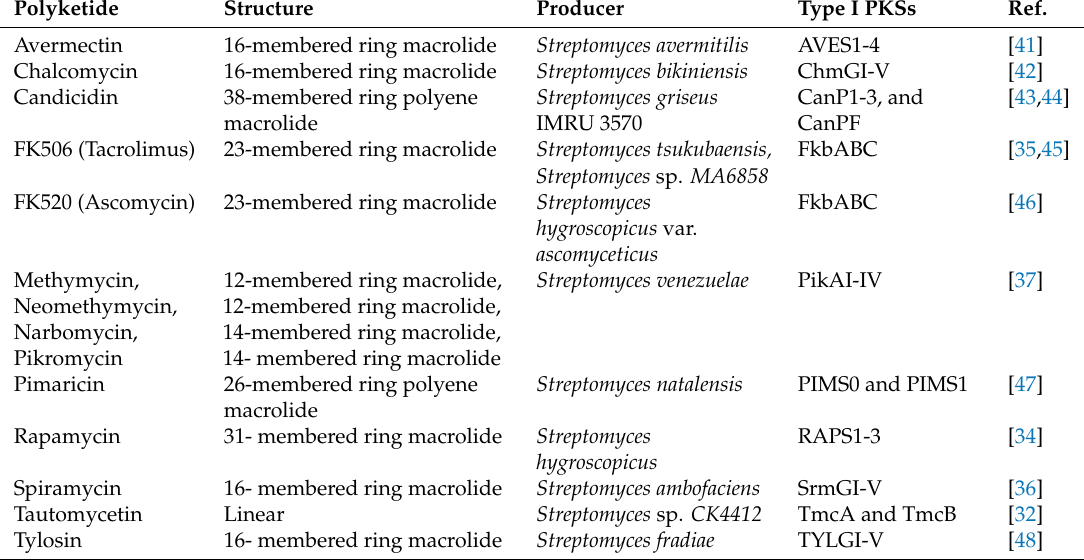
Table 1. Some polyketides produced by Streptomyces and their type I